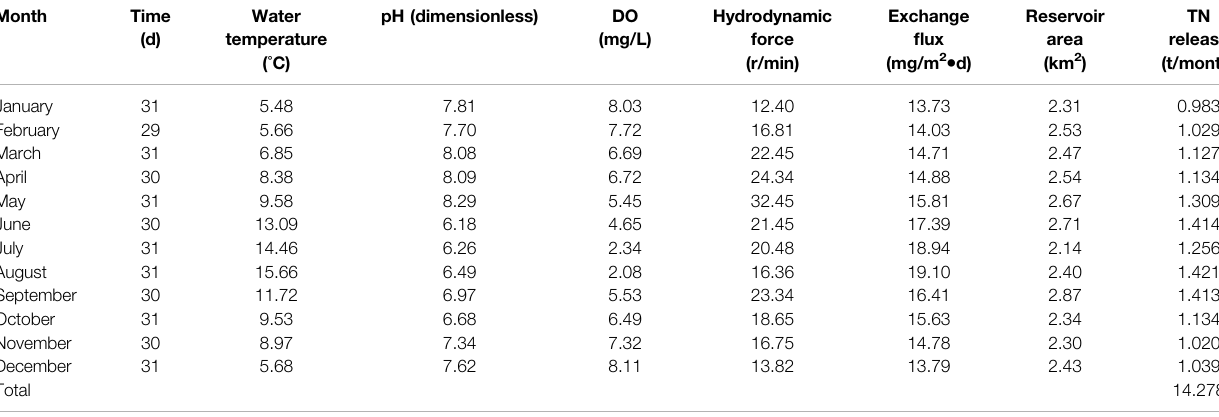
TABLE 3 | Estimation of the TN release pollution load from the sediments in the Dahekou Reservoir.